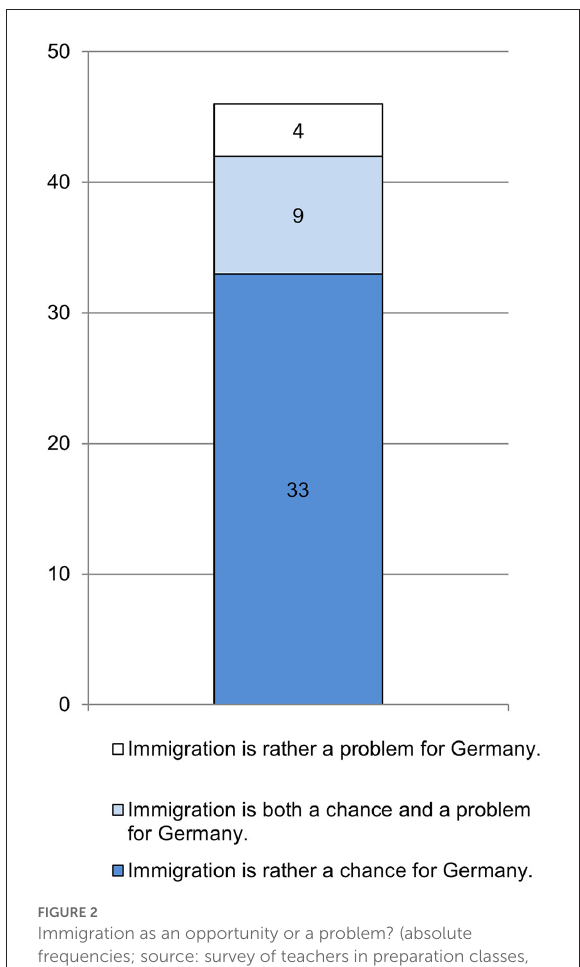
FIGURE2 Immigration as an opportunity or a problem? (absolute frequencies; source: survey of teachers in preparation classes, n =